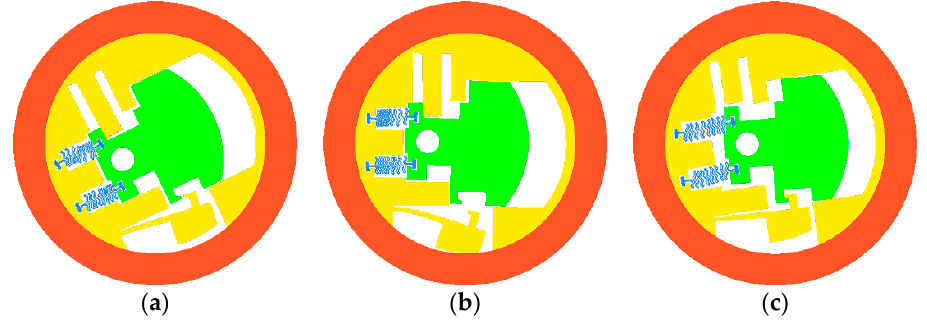
Figure 5. The simulation results for the micro S & A module under the different rotary speed curves. ( a ) curve 1 and the electric thruster does not work; ( b ) curve 2 and the electric thruster does not work; ( c ) curve 3 and the electric thruster works.